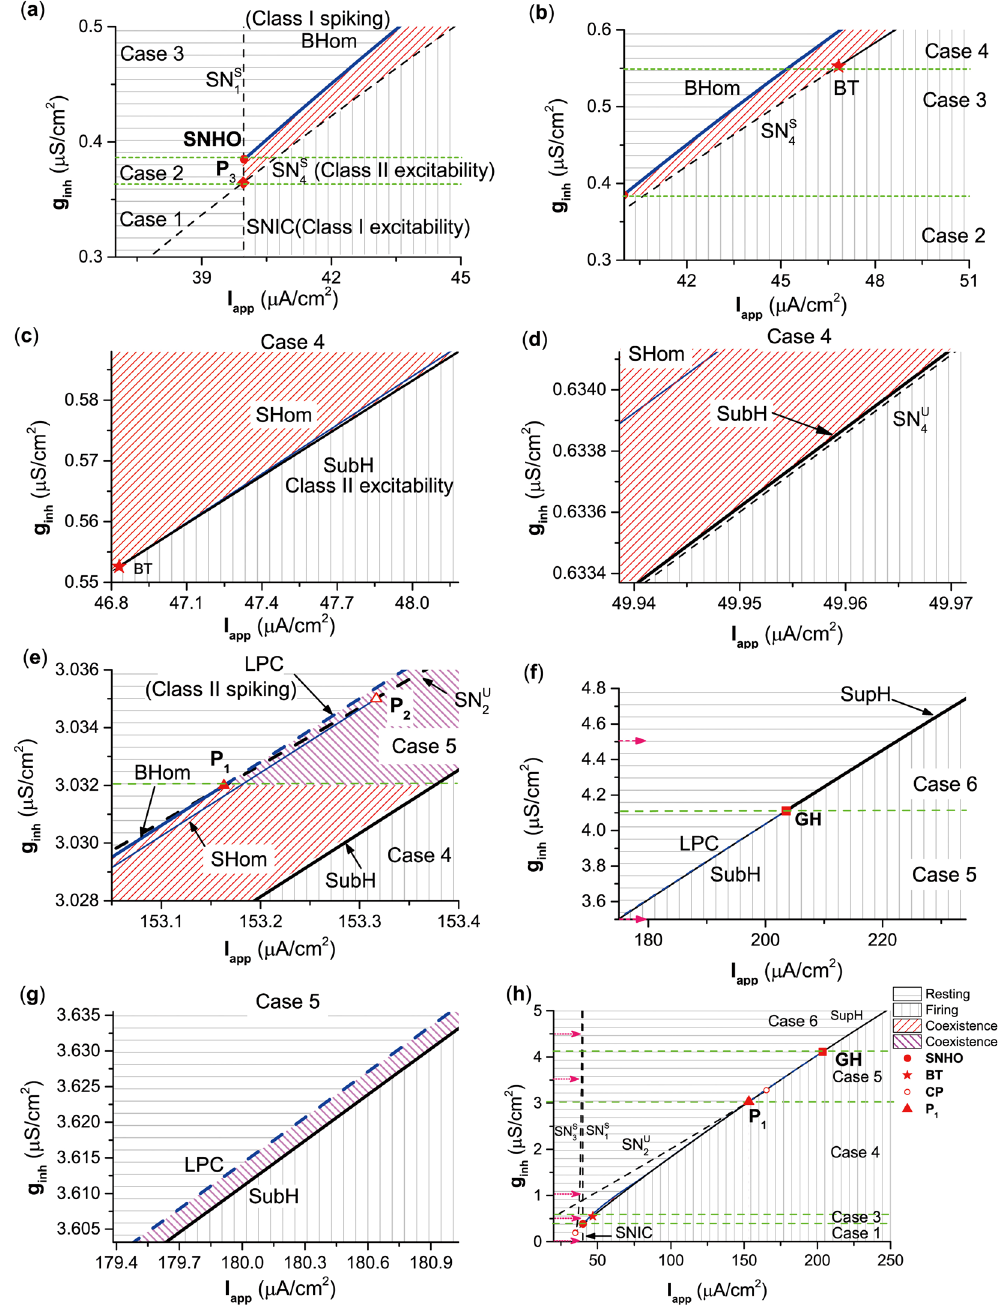
Figure 5. Two-parameter bifurcations in the plane ( I app , g inh ) of the ML model with an inhibitory autapse. ( a ) Partial enlargement of the bifurcation diagram around SNHO and P 3 . ( b ) Partial enlargement of the bifurcation diagram around BT. ( c ) Partial enlargement of the bifurcation diagram is up and to the right of BT in ( b ). ( d ) Further amplification is up and to the right of BT in ( b ). ( e ) Partial enlargement of the bifurcation diagram around P 1 . ( f ) Partial enlargement of the bifurcation diagram around GH in ( h ). ( g ) Partial enlargement of the bifurcation diagram is up and to the right of GH. ( h ) Global view of the bifurcation diagram. Figure ( a – f ) is a part of Fig. ( h ). SNIC represents the curve of saddle-node bifurcation on an invariant circle. SubH and SupH are subcritical Hopf curve and supercritical Hopf curve, respectively. BHom and SHom are saddle homoclinic orbit bifurcation curves. SN iS and SN iU ( i = 1, 2, 3, 4) are curves of saddle node bifurcation of equilibrium. LPC represents the curve of saddle node bifurcation of limit cycle. CP is cusp bifurcation. BT is Bogdanov-Takens bifurcation. SNHO is saddle-node separatrix-loop. GH is Bautin